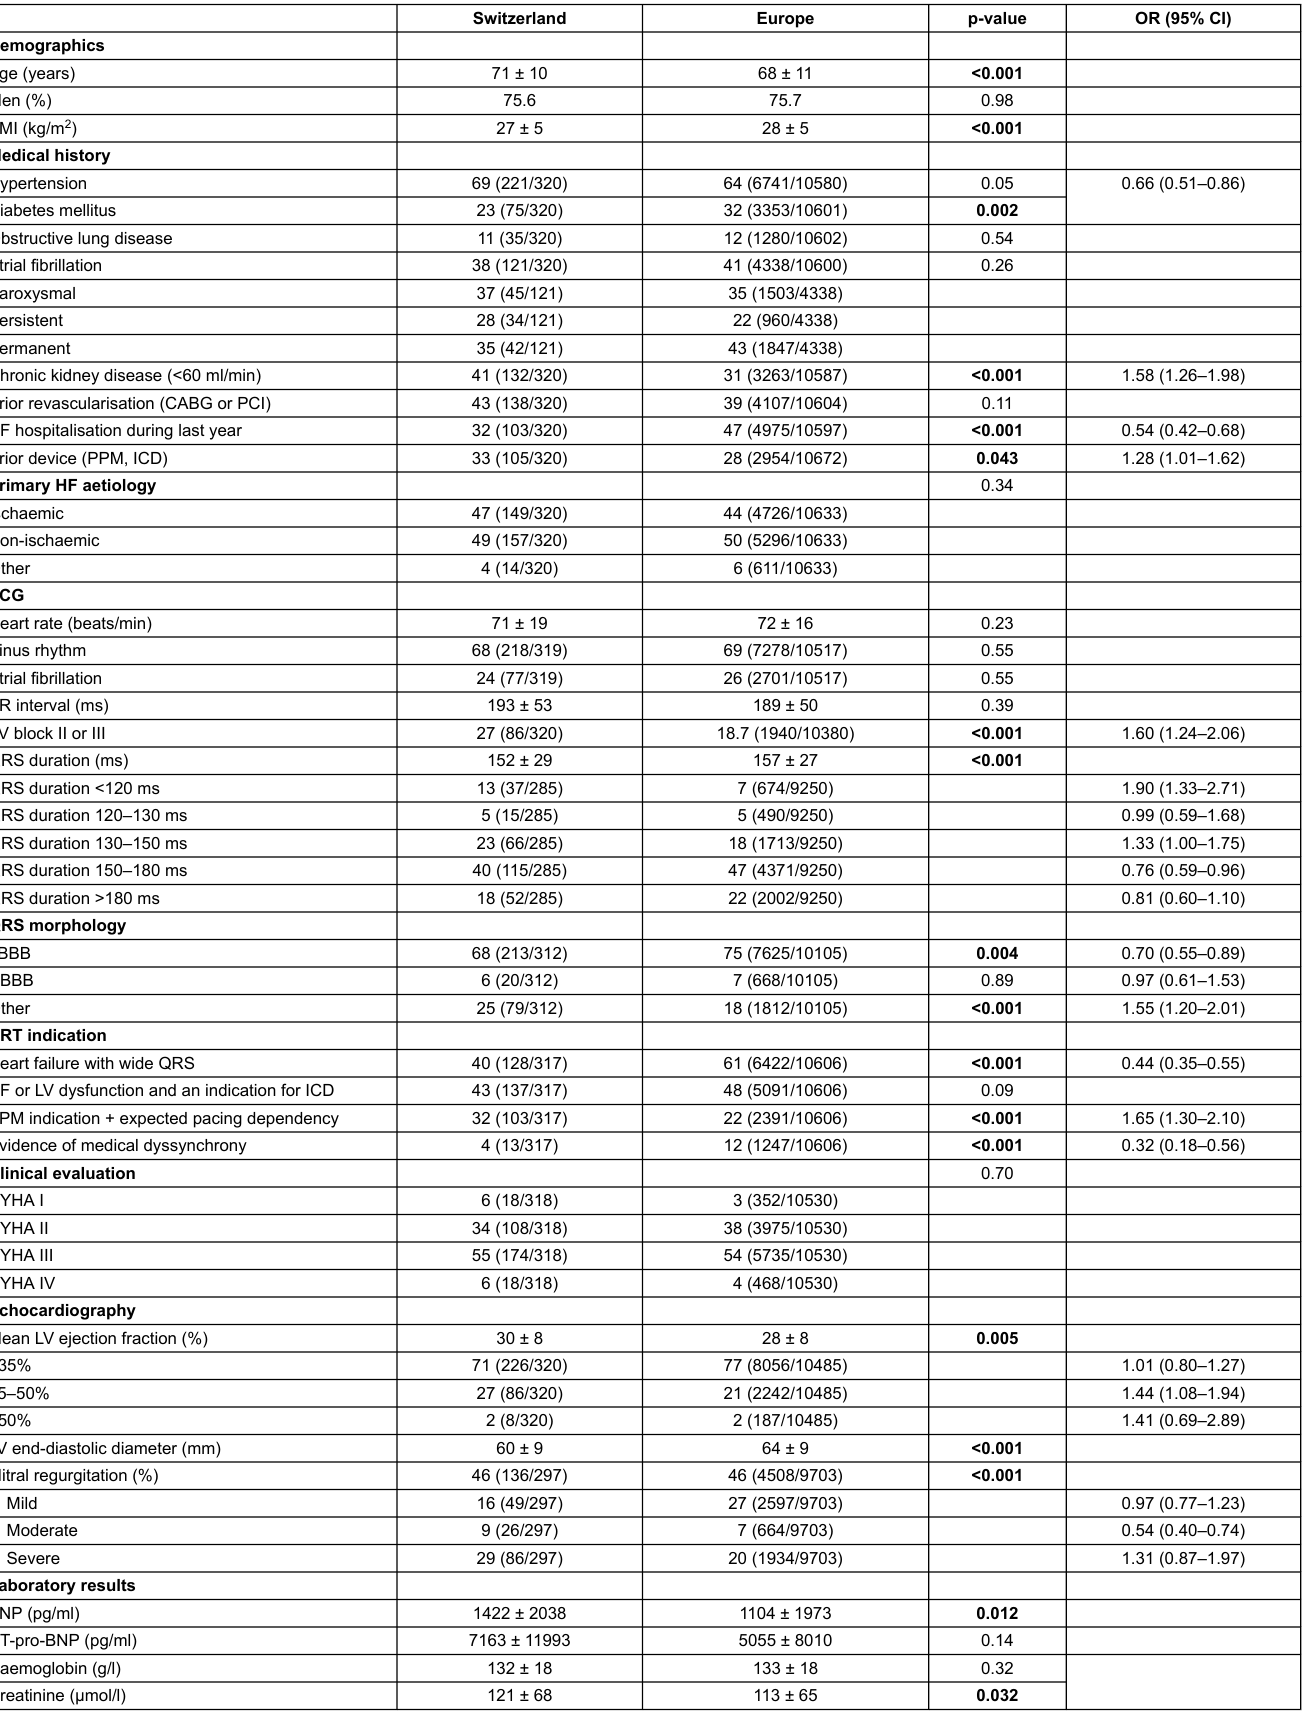
Table 2: Baseline characteristics and pre-procedural data of Swiss cardiac resynchronisation therapy (CRT) population and comparison with the European